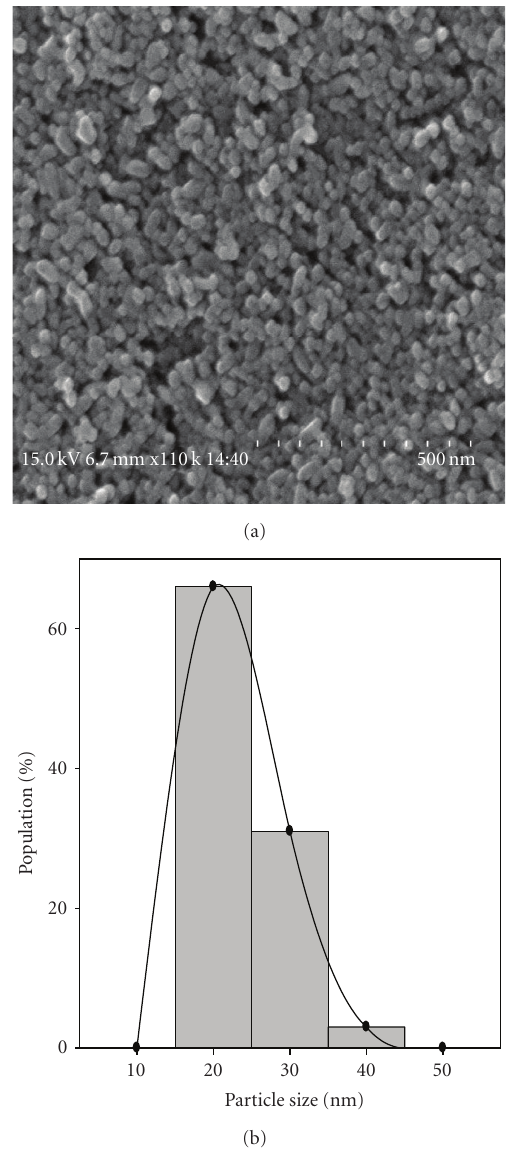
Figure 3: TTIE-TiO 2 thin film morphology after annealing at 500 ◦